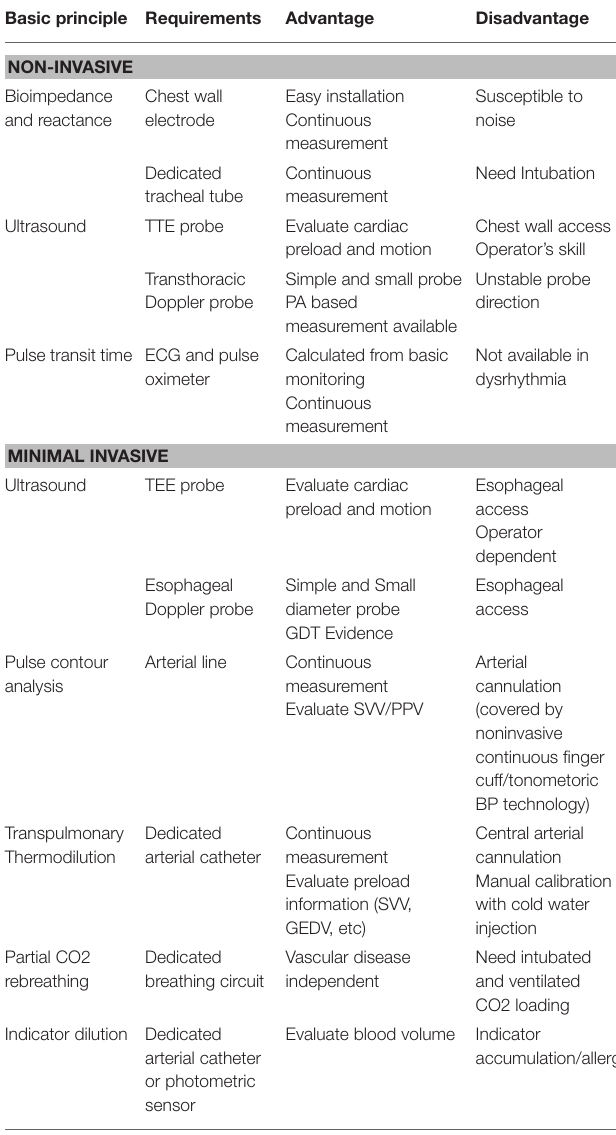
TABLE 2 | Non-minimal invasive continuous cardiac output